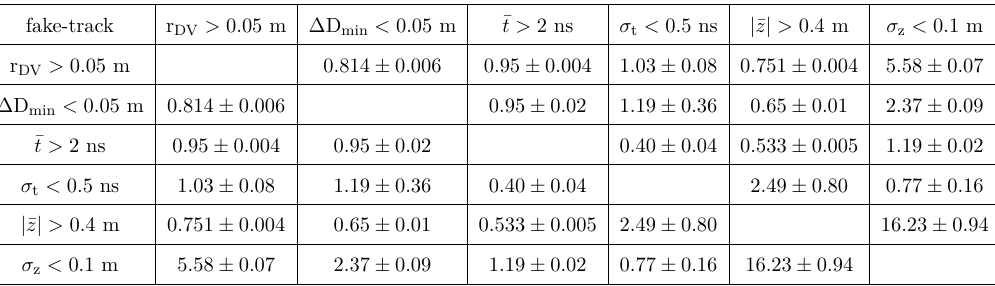
Table 7 . The correlation table for vertexing-cuts variables for fake-track backgrounds. These cuts are weaker than the cuts in table 3.